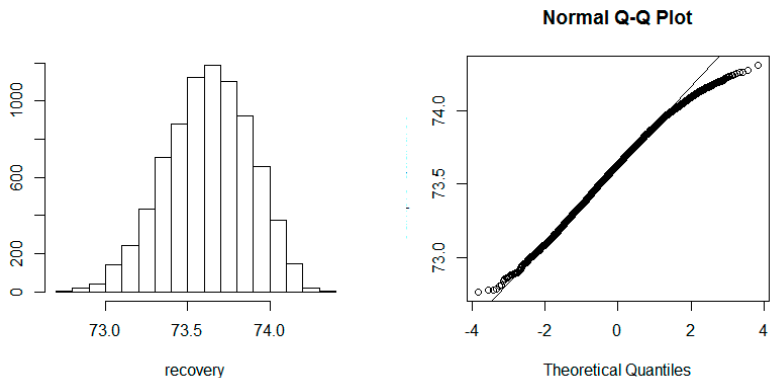
Figure 2. Uncertainty analysis at 100 days of leaching.